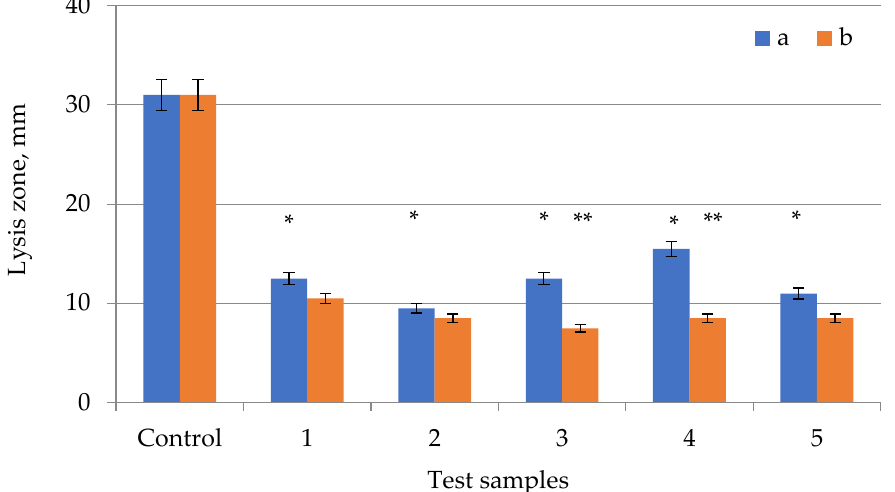
Figure 4. Testing the antimicrobial effect against Candida albicans of Eucalyptus globulus extracts of different extraction times (a) with US treatment and (b) without US treatment: 1—10 min; 2—15 min; 3—20 min; 4—25 min; 5—30 min. Control—fluconazole (2 mg/mL). Values of the treated and control cultures followed by the symbol “*” do differ significantly ( p < 0.05) as assessed by post hoc test (Tukey test). Values of the treated culture at same time followed by the symbol “**” do differ significantly ( p < 0.05) as assessed by post hoc test (Tukey test). Table 1. Inhibition zone of Eucalyptus globulus extracts and ampicillin against various strains of microorganisms.